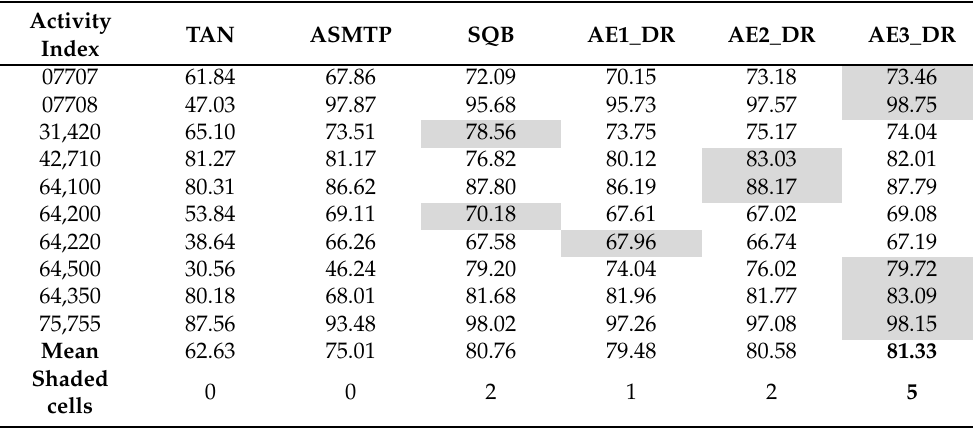
Table 6. The Retrieval results of top 1% for MDDR-DS2